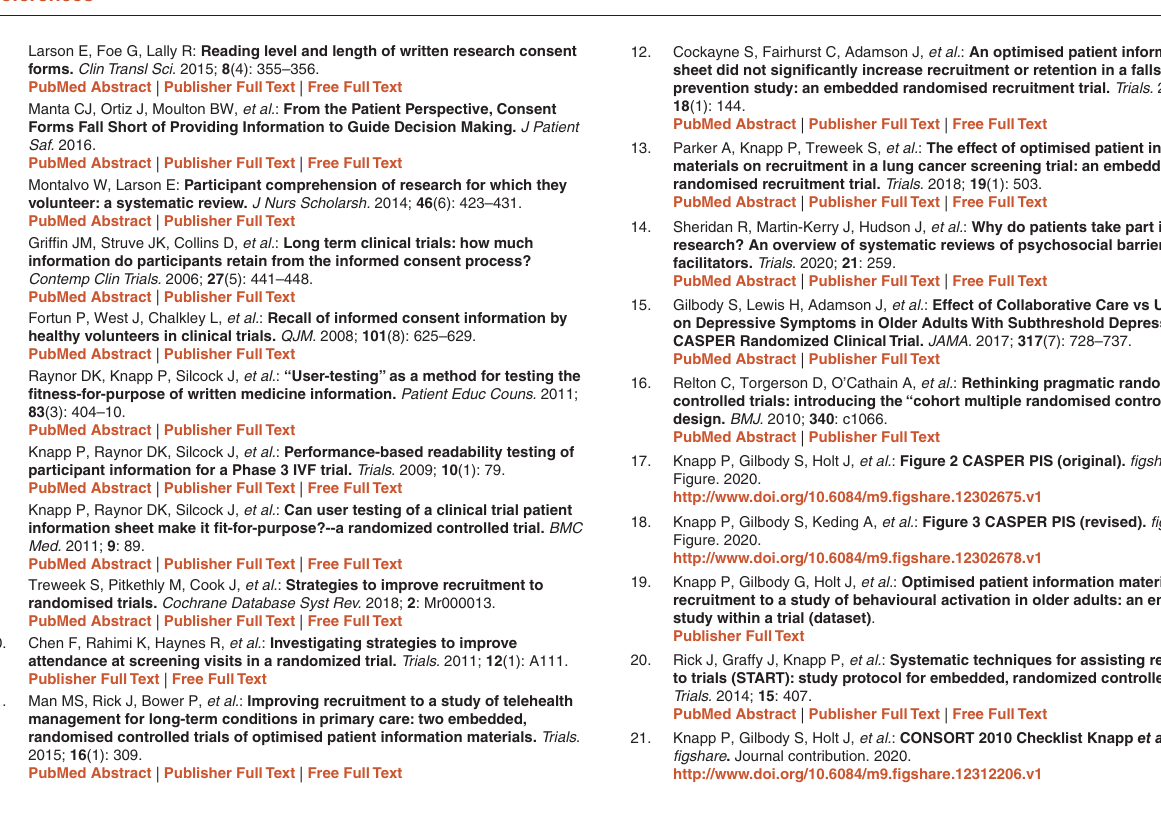
Figshare: CONSORT checklist for ‘Optimised